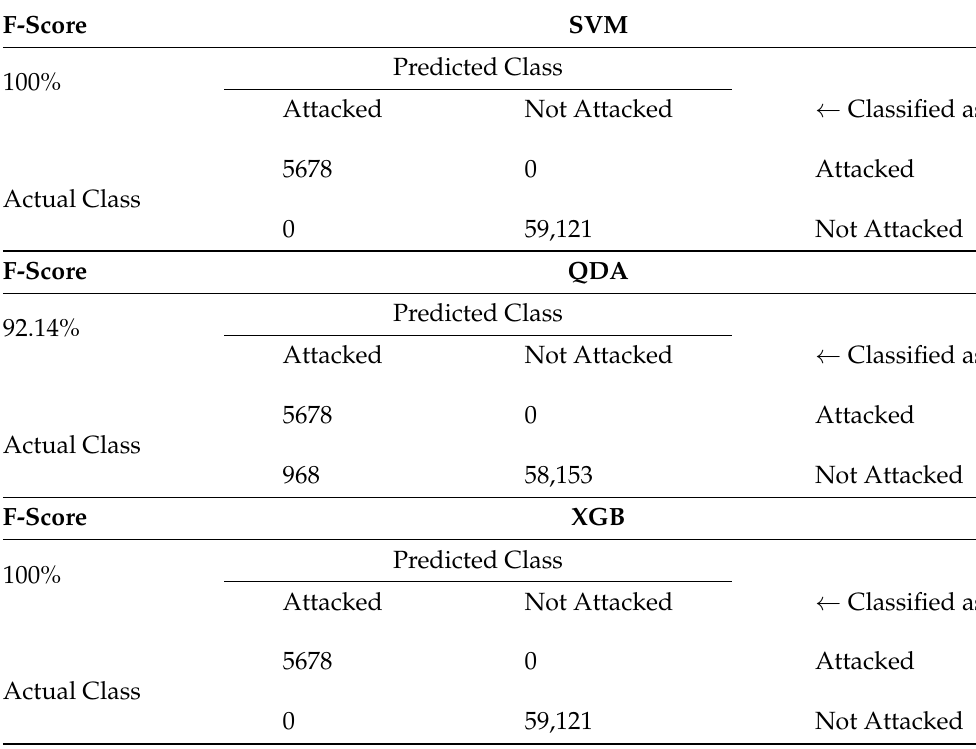
Table 7. Sample of the performance for scenario